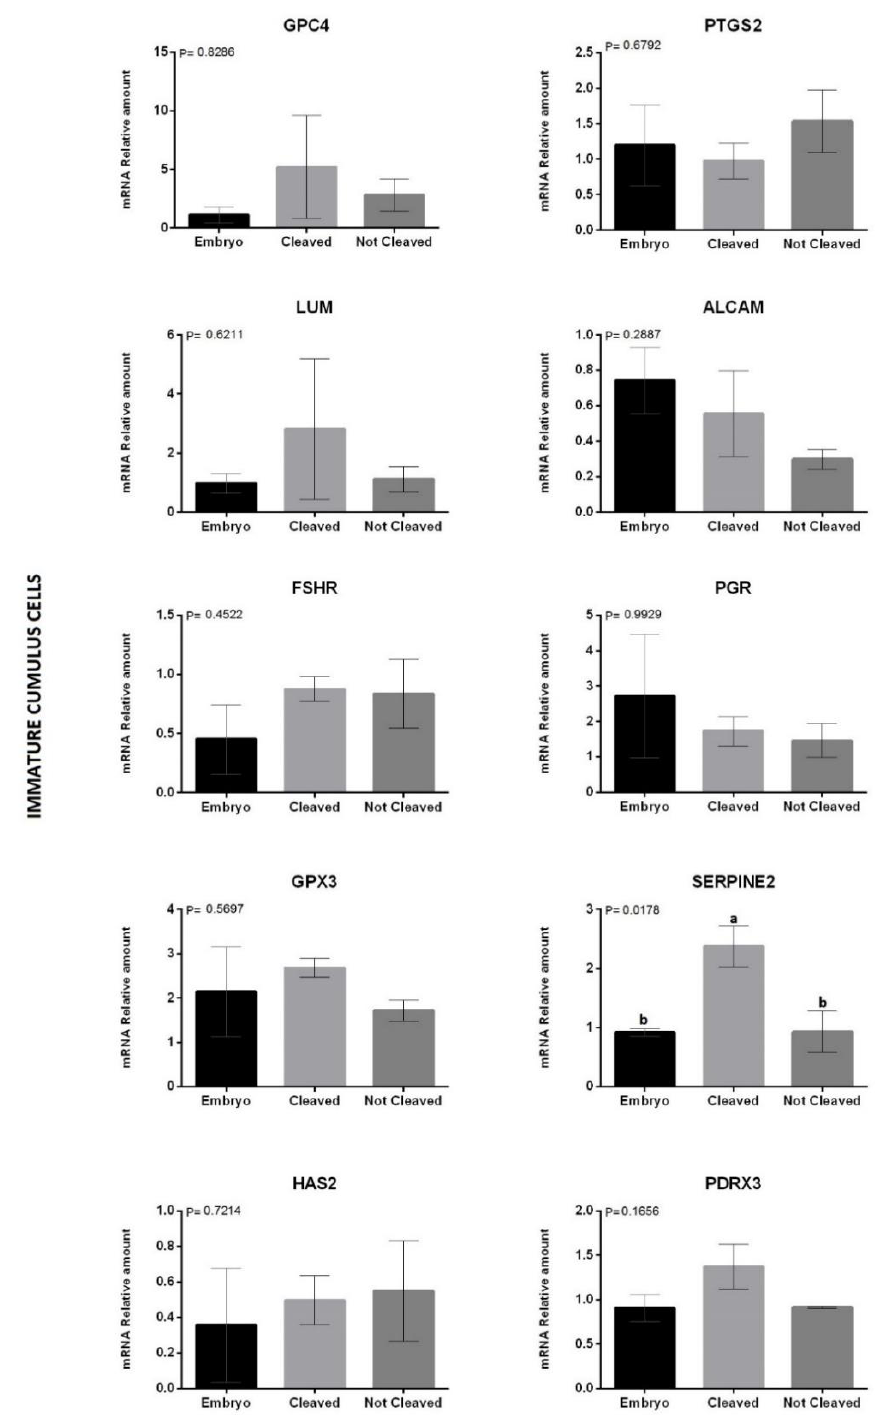
Figure 2. Relative abundance of messenger RNA (mRNA) encoding GPC4, PTGS2, LUM, ALCAM, FSHR, PGR, GPX3, SERPINE2, HAS2, and PRDX3 genes determined by quantitative polymerase chain reaction. Samples acquired on immature CCs biopsy from COCs that developed until embryo (black bar); cleaved but did not develop (bright gray bar) or did not cleave (dark gray bar) after IVM, IVF, and IVC. Mean ± standard error of the mean (SEM) of three biological replicates. The data were normalized using the formula DDCT by Pfaffl [46], with GAPDH as an endogenous control. a,b Statistically significant differences between treatments. The differences were significant when p < 0.05, according to the T